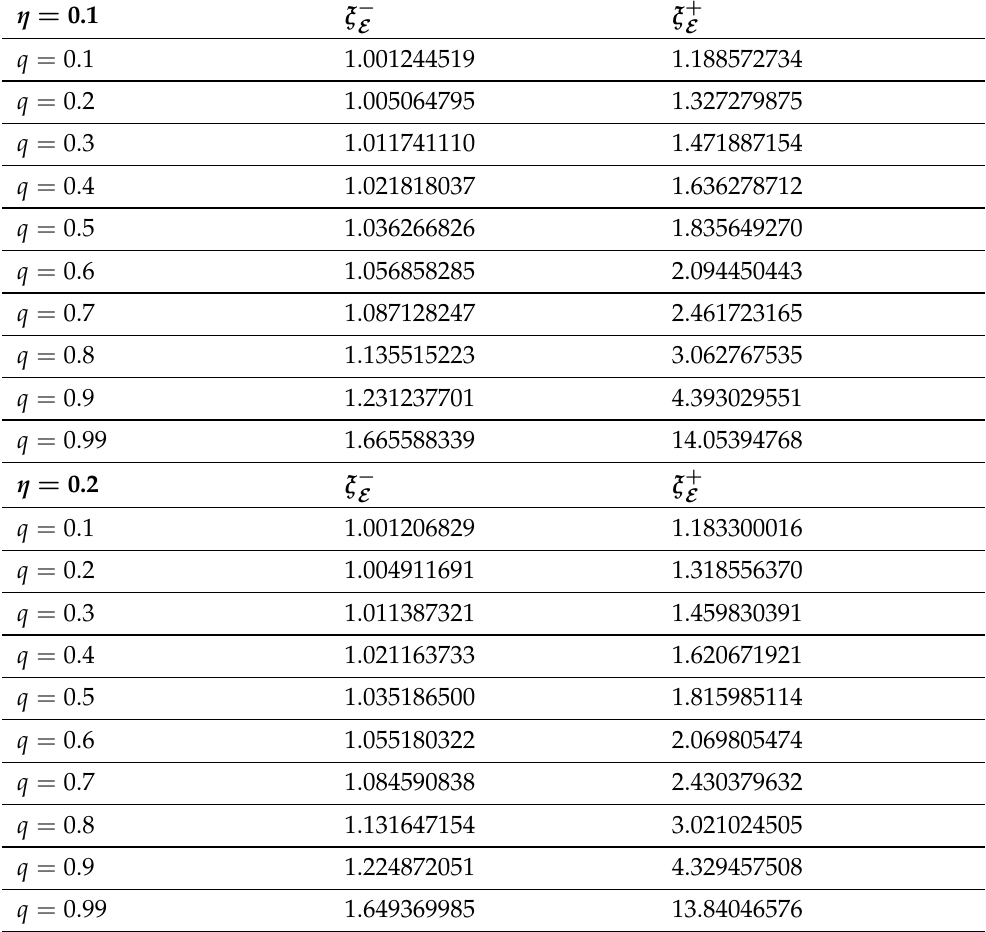
≤ q ≤ 0.99 and 0.1 ≤ η ≤